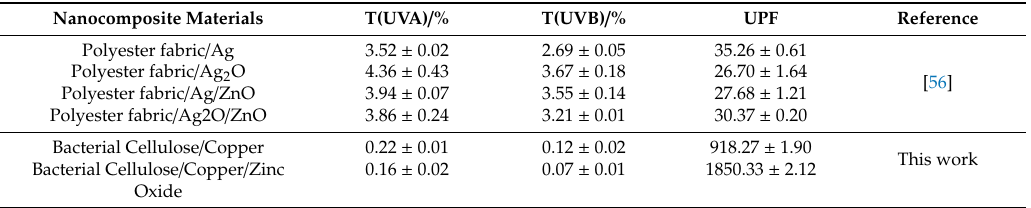
Comparison of di ff erent nanocomposite materials in terms of ultraviolet resistance